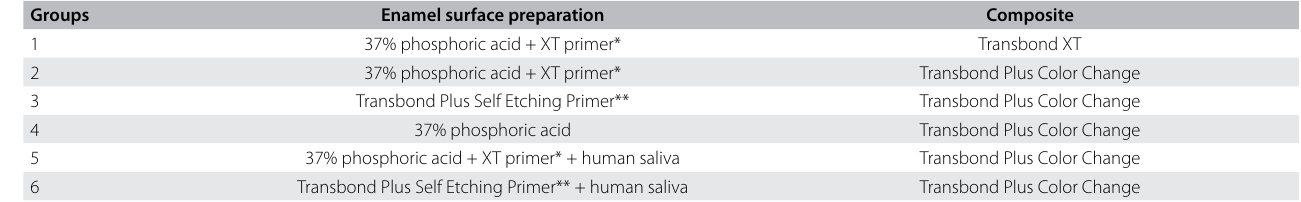
Table 1. Experimental Groups